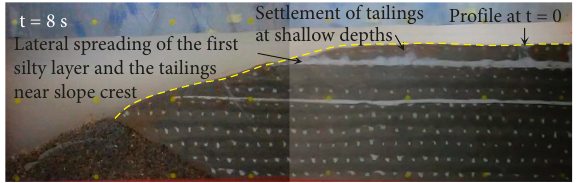
Figure 6: Snapshot of the tailings impoundment at t �